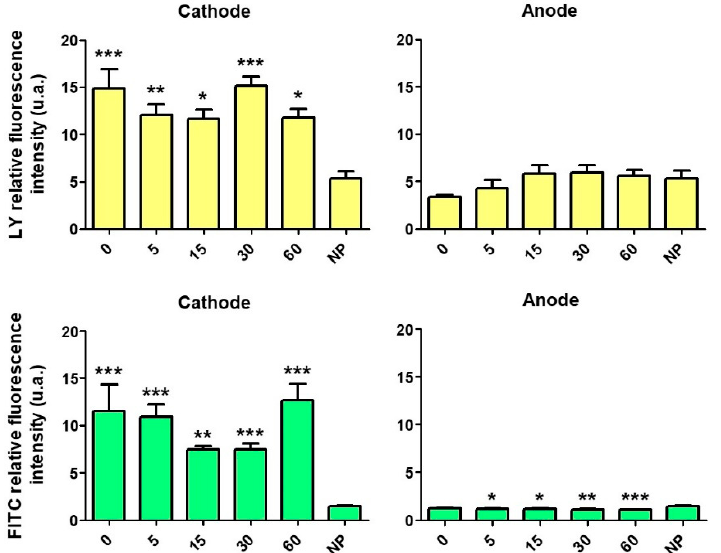
Figure 5. Effect of the duration of contact between skin and platforms after EP treatment. Platforms loaded with either LY or FD4 (1 mM), were used to apply unipolar EP treatment on hairless mice skin explants. The duration of contact between skin and platforms after treatment was increased to see the contribution of electrophoresis and passive diffusion. Quantification of LY and FITC RFI at the cathode and anode of skins treated with unipolar-pulsed electric field and platforms loaded with either LY or FD4. Platforms were left 0, 5, 15, 30 or 60 min on the skin after treatment. Statistical analysis: one-way ANOVA, Dunnett’s post-test vs. NP data. Codes signification: * = p > 0.05; ** = p > 0.01; *** = p > 0.001; else is non-significant. Error bars indicate SEM. n = 3–9.